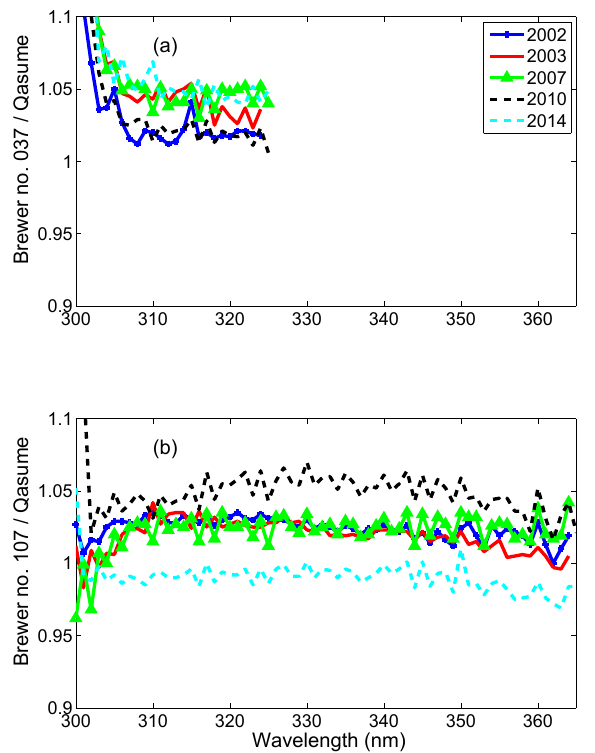
Figure 9. The results of the comparisons between (a) Brewer no. 037, (b) Brewer no. 107 and the QASUME during 2002–2014. The irradiances of the Brewers were cosine error